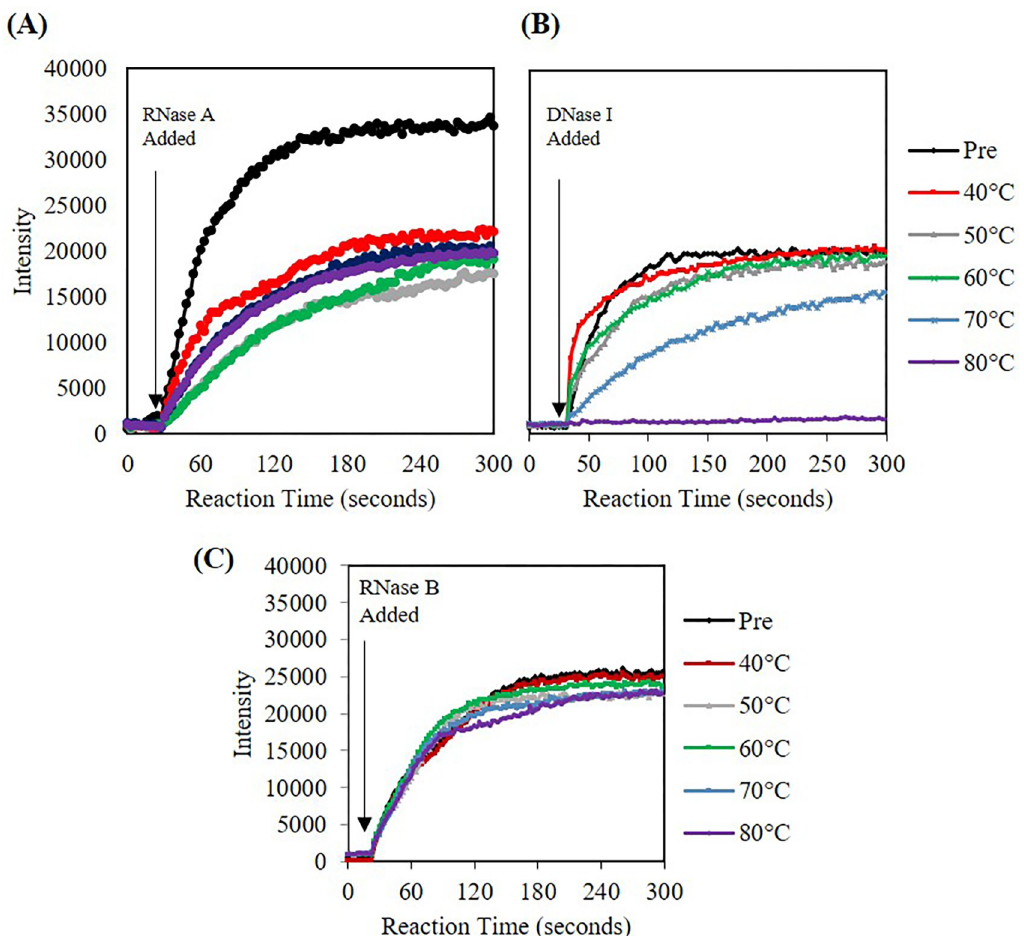
Fig 7. Fluorescent intensity at 520 nm (RNase A) and 556 nm (DNase I) and 520 nm (RNase B) versus time for conventionally heated (1 minute) nucleases. (A) RNase A (B) DNase I (C) RNase B. For RNase A and DNase I, as temperature increases, the activity of the nucleases decreases. For RNase B, the rate is statistically different at 70˚C and 80˚C.